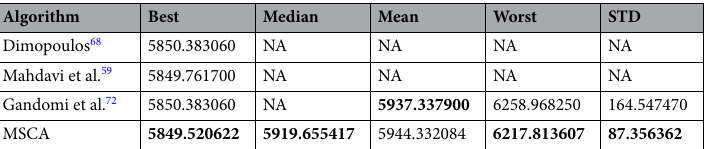
Table 24. Statistical result for pressure vessel design problem on version II. NA means not available. Significant values are in